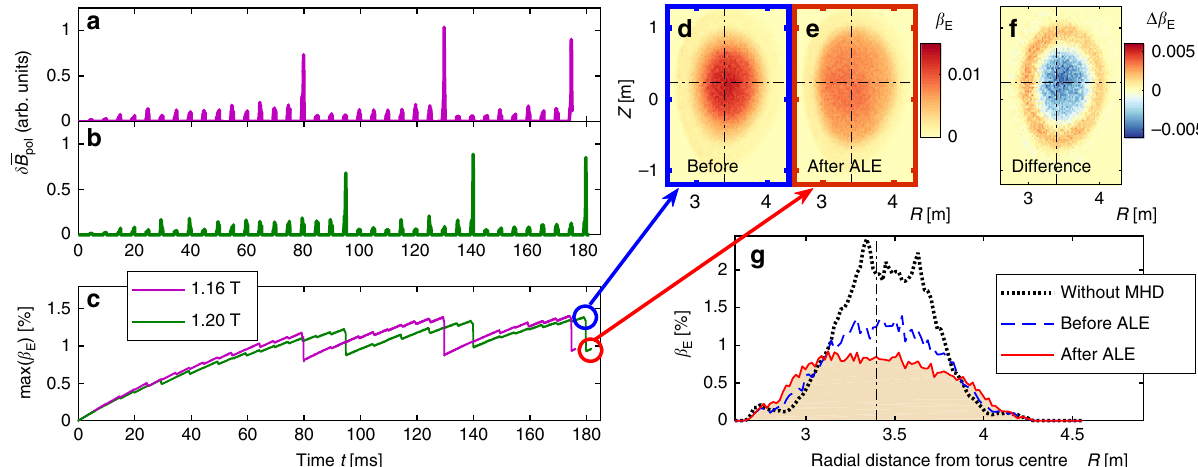
Fig. 3 Long-time simulations of multiple ALE cycles. Two simulations were performed with different background magnetic fi eld strengths, B 0 = 1.16T and 1.20T, while fi xing the beam-to-Alfvén velocity ratio v 0 / v A0 = 1.432. Panels a and b show the respective time traces of the magnetic fl uctuation amplitude δ (cid:1) B . Panel c shows the evolution of the peak value of the beta parameter β E for energetic ions with energies above 80 keV. During each ALE, max( β E ) pol drops abruptly as beam ions migrate from the plasma core into the periphery. The extent of this spatial redistribution can be seen in panels d – f , where we compare snapshots of β E ( R , Z ) before and after the ALE at t = 180 ms in the B 0 = 1.20T case. Panel g shows the radial pro fi le β E ( R ) before and after the ALE at the height of the plasma midplane ( Z 0 = 0.2 m). For comparison, the dotted curve in g shows the overestimated β E ( R ) pro fi le that one obtains when MHD activity is ignored. The dash-dotted lines in d – g indicate the position of the plasma centre; namely, the magnetic